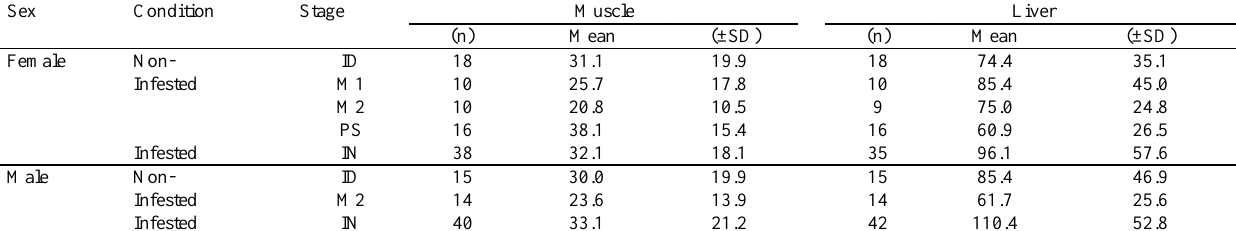
Table 2 . Total mercury concentrations (mean ± SD and range in ng.g -1 wet weight) in muscle and liver of Cyphocharax gilbert fish non-infested and infested by Riggia paranensis at different reproduction stages, from the middle Itabapoana River, Brazil. The gonadal development stages are: ID, initial development; M1, maturating; M2, mature; PS, post-spawning, and IN, inhibited by